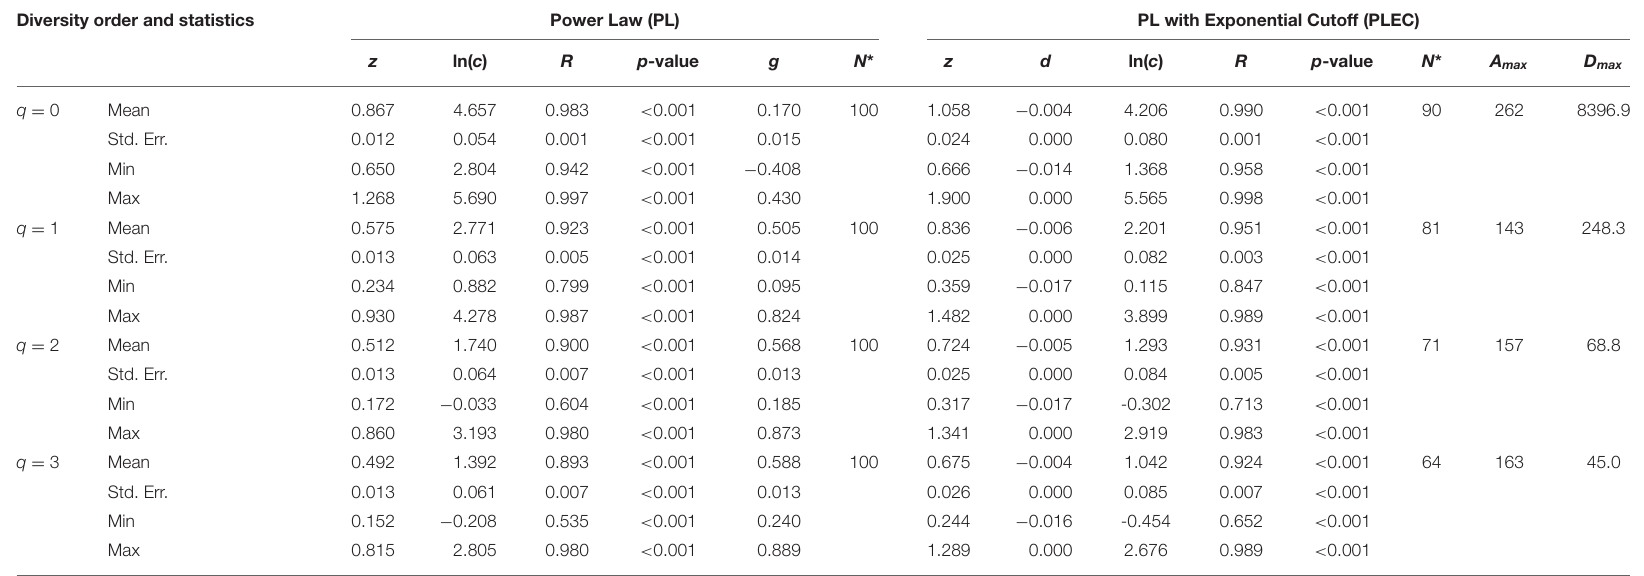
TABLE 1 | The parameters of DAR (diversity-area relationship) for the Archea in the hot springs, computed with 100 times of re-sampling from the totally permutated hot springs. Diversity order and